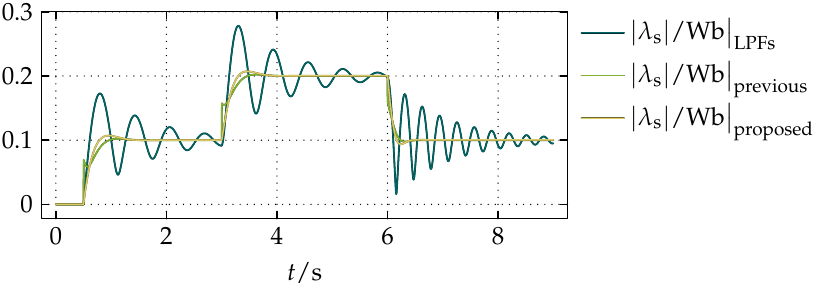
Figure 11. The results of λ s obtained by a comparative simulation of the standard solution with LPFs | | presented in [5–11], the previous compensation presented in [23], and the proposed compensation.